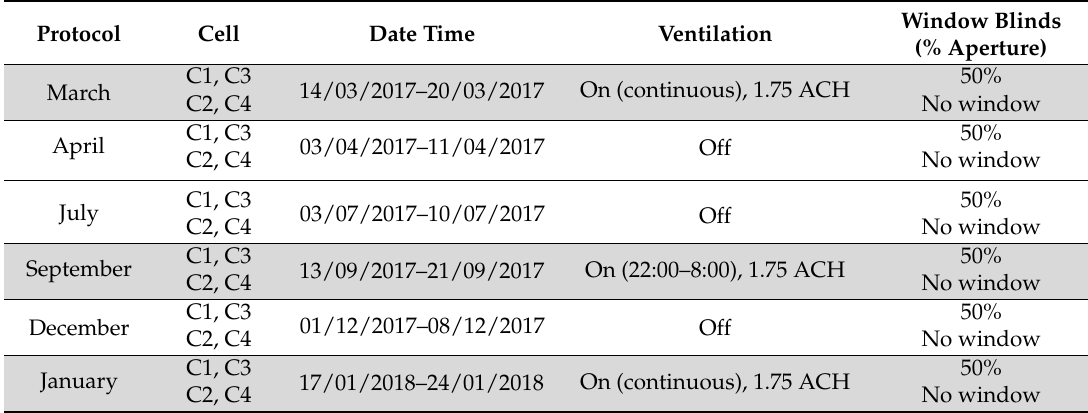
Table 3. Characteristics of protocols analysed in free-running